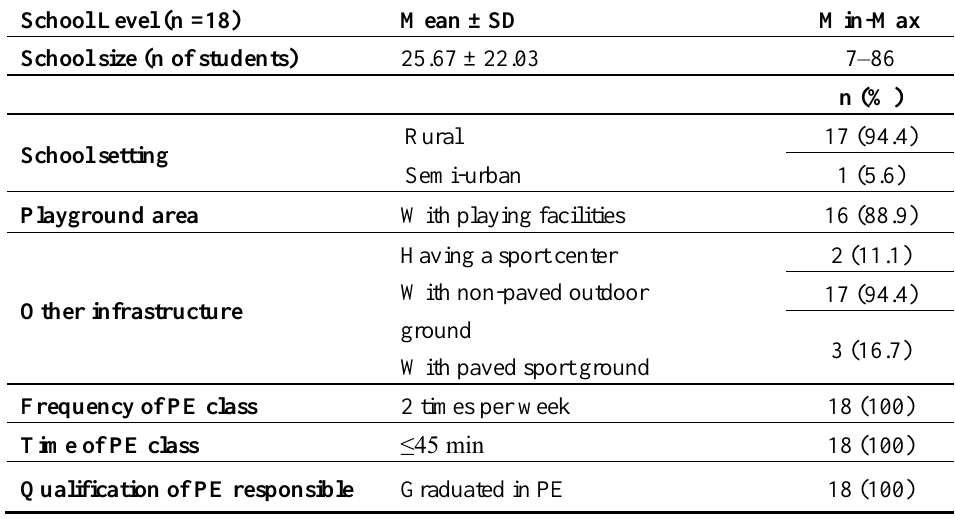
Table 2. Descriptive statistics for all variables at school level (level